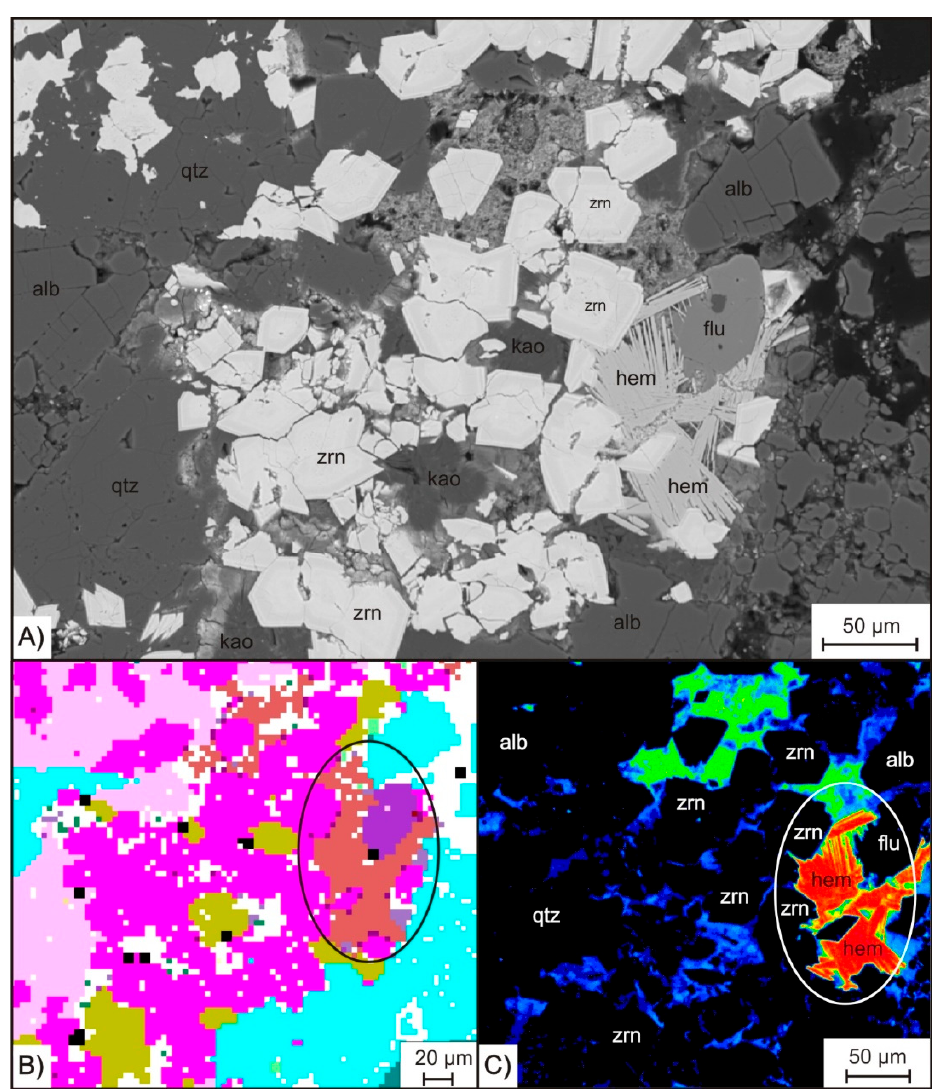
Figure 5. ( A ) Back scatter (BSE) image of a zircon cluster. Hematite (hem) as fibrous shape crystals in interstitial volume between zircons (zrn) and one fluorite (flu) crystal. ( B ) 5 QEMSCAN© phase map with 5 µm point spacing showing the hematite intergrowth in a close up of the cluster displayed in A. ( C ) Electron probe micro analyser (EPMA) high-resolution Fe map revealing Fe fine cementation as blue color surrounding individual zircon crystals. Other minerals: quartz (qtz), kaolinite (kao), albite (alb).